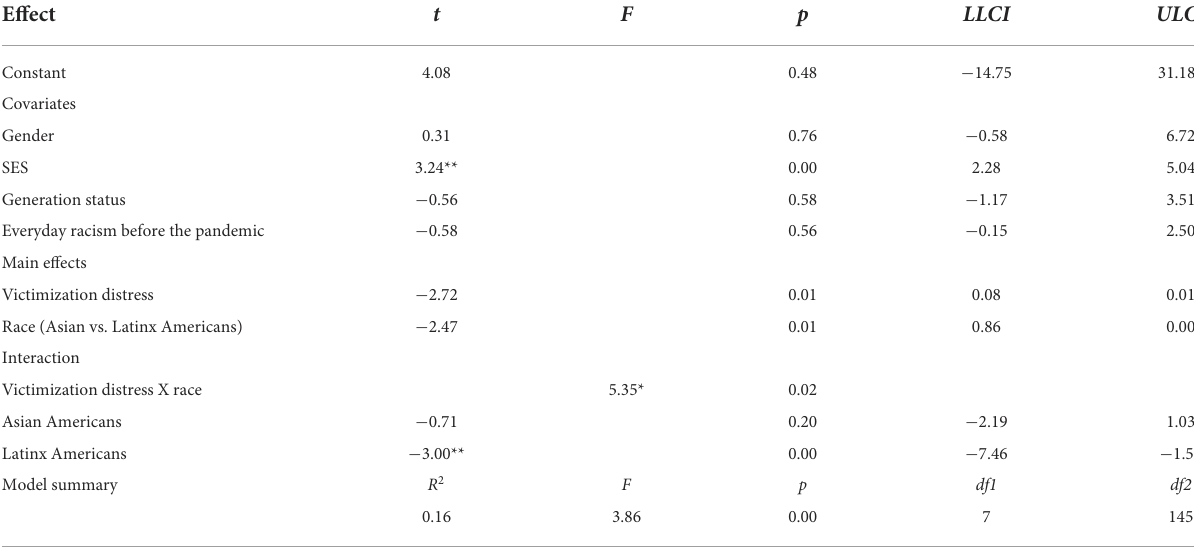
TABLE 7 Moderation results for victimization distress and race (Asian vs. Latinx Americans) with well-being as the outcome and everyday racism before the pandemic, gender, SES, and generation status as covariates for study